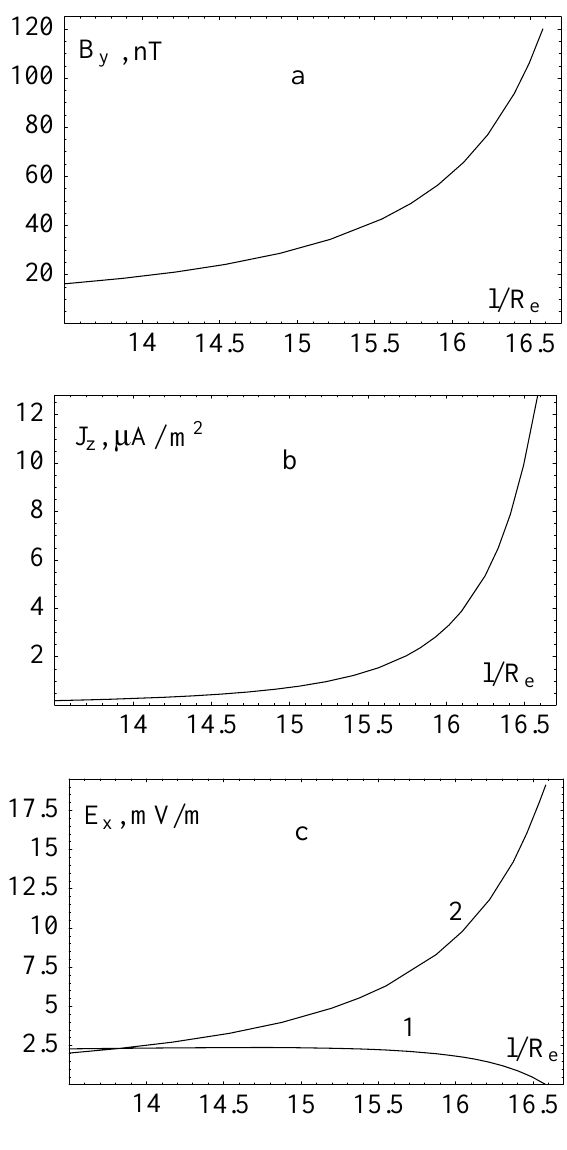
Fig. 11. Dependence of the azimuthal magnetic field (a) , parallel electric current (b) , and transverse electric field ( (c) , in-phase, 1, and quadrature, 2, components) on the coordinate along the mag- netic field line. Only part of magnetic field line close to the iono- sphere is shown. Amplitudes are taken at the time of FLR satu- ration. The ionospheric end corresponds to l max = 16 . 6 R E , the FAST altitude corresponds to l = 16 R E